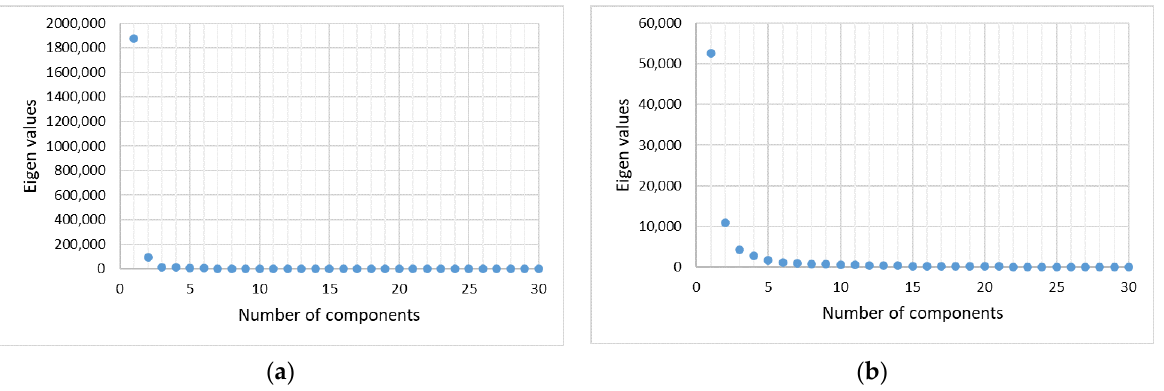
Figure 2. Determining the number of components by singular value decomposition: ( a ) set of raw Raman spectra, ( b ) set of preprocessed Raman spectra.